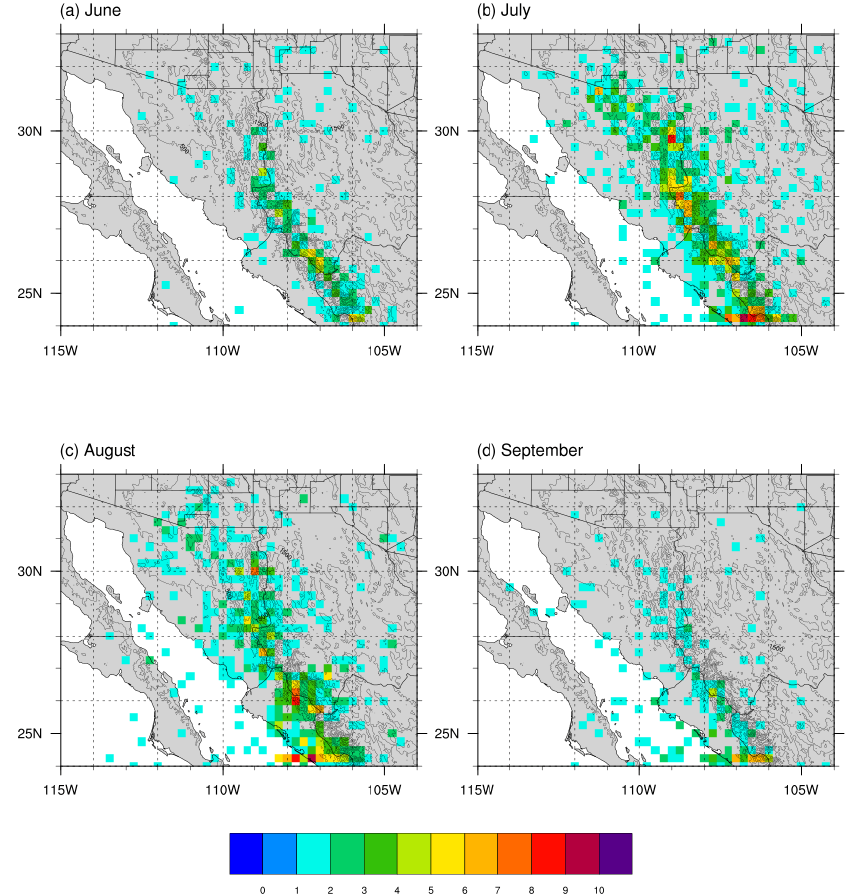
Figure 6. Geographic distribution of MCS initiation from June through September ( a – d ), by month, where the color bar represents counts for the given month. The topography contours every 500 m are represented by the gray